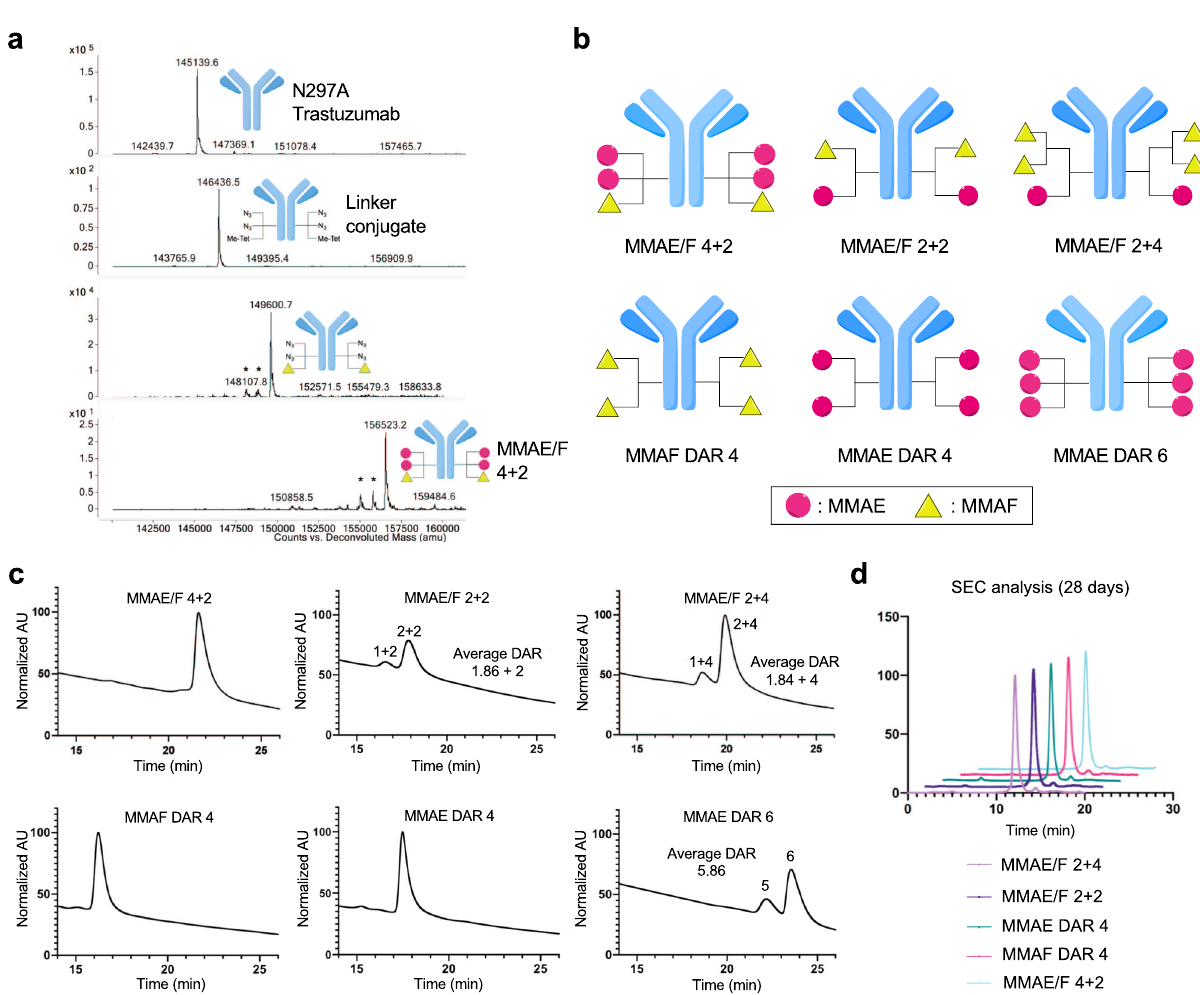
Fig. 2 Construction and characterization of dual-drug ADCs. a Deconvoluted ESI-mass spectra. First panel: intact N297A anti-HER2 mAb (trastuzumab mutant). Second panel: antibody – branched linker conjugate. Third panel: intermediate after conjugation with TCO – MMAF modules. Fourth panel: highly homogeneous dual-drug ADC with a DAR of 4 + 2 (MMAE + MMAF). *Fragment ions detected in ESI-MS analysis. b Diagrams illustrating dual-drug and single-drug ADCs prepared and evaluated in this study. Magenta circle: MMAE; yellow triangle: MMAF. See Supplementary Notes for characterization details. c Hydrophobic interaction chromatography (HIC) analysis of ADCs under physiological conditions (phosphate buffer, pH 7.4). The number of conjugated MMAE has a greater contribution to ADC hydrophobicity than does MMAF. d Overlay traces of size-exclusion chromatography (SEC) after incubating each conjugate in PBS (pH 7.4) at 37 °C for 28 days. MMAE/F 2 + 4 ADC (light purple), MMAE/F 2 + 2 ADC (dark purple), MMAE DAR 4 ADC (green), MMAF DAR 4 ADC (magenta), and MMAE/F 4 + 2 ADC (cyan). Retention times of all major peaks were similar (12 min). No signi fi cant aggregation was detected in either